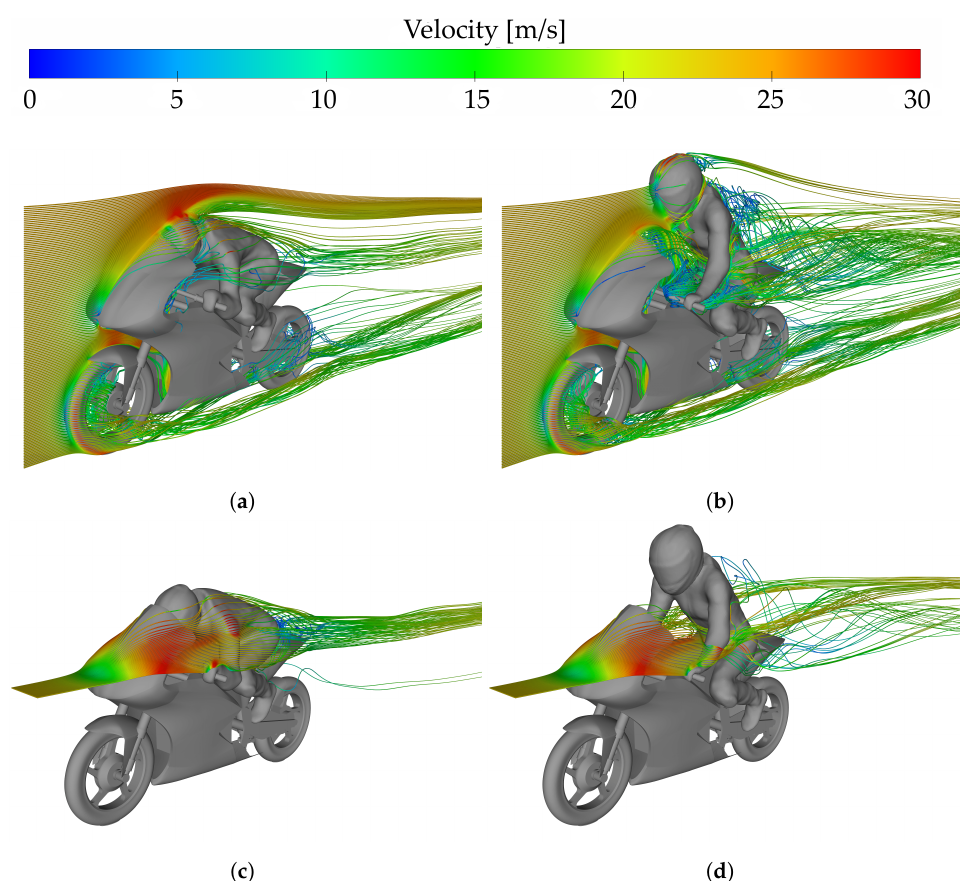
Figure 22. Streamlines coloured by velocity for motorcycle and a rider in a low-drag position ( a , c ) and in upright position ( b , d